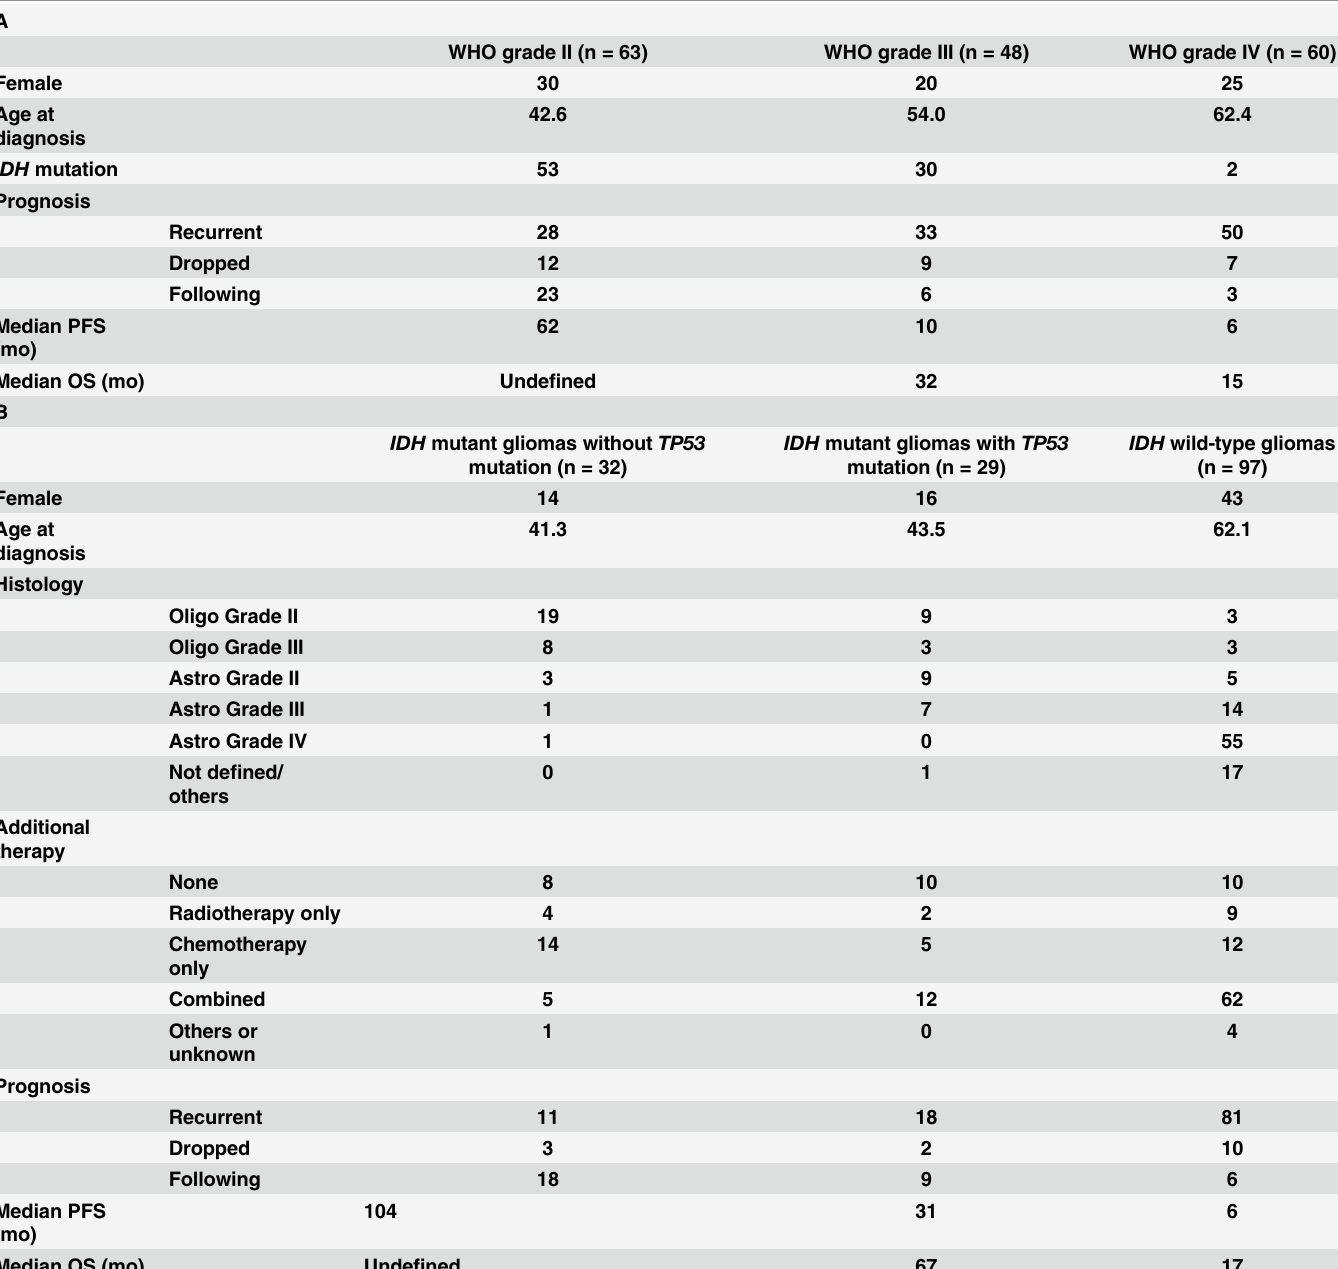
Table 1. Background of patients who underwent initial surgical